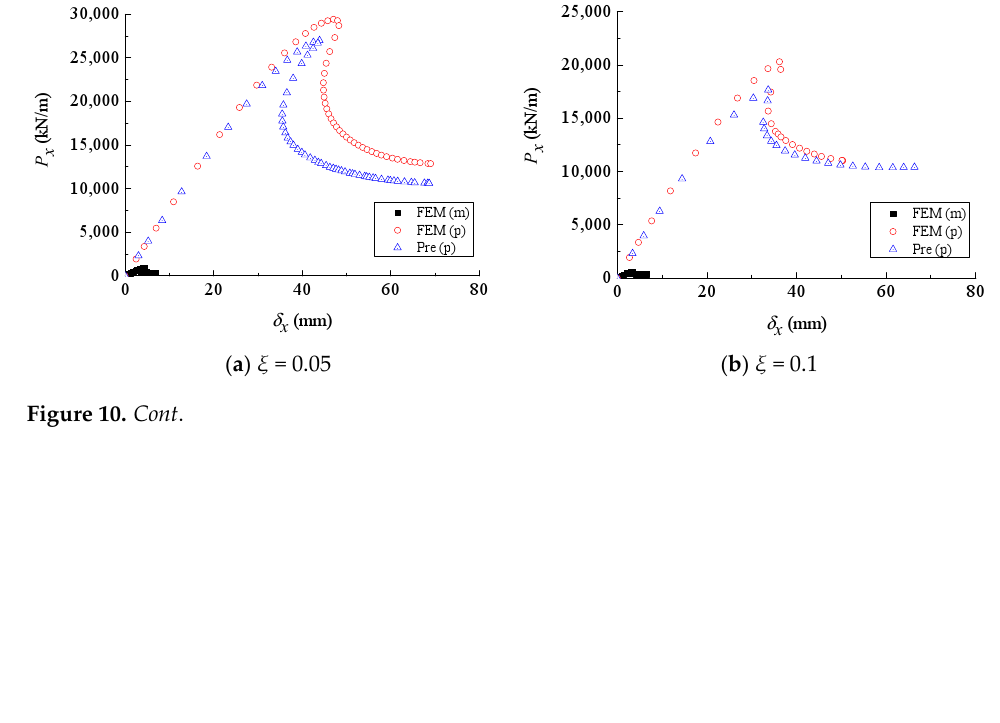
Figure 9. Radial displacement contour map at the critical point of the post-buckling path for the model of the stiffened cylinders with L / R = 2.51 and the SS3 boundary condition when the material is PVC and ξ = 0.05.